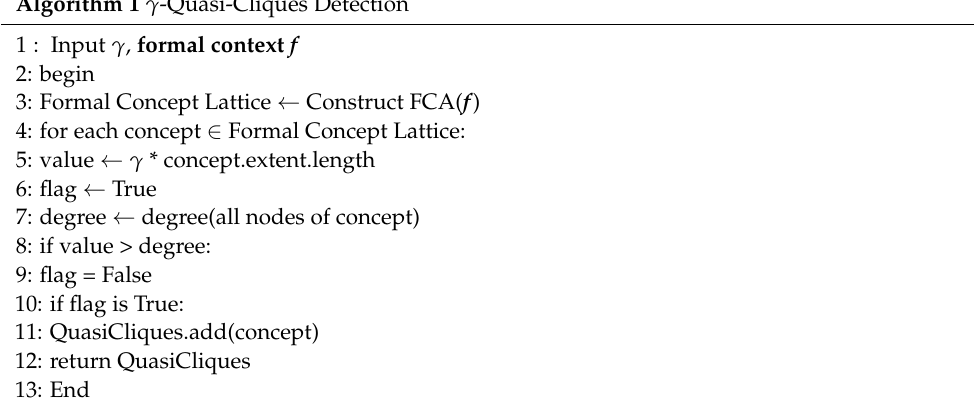
Algorithm 1 γ -Quasi-Cliques Detection